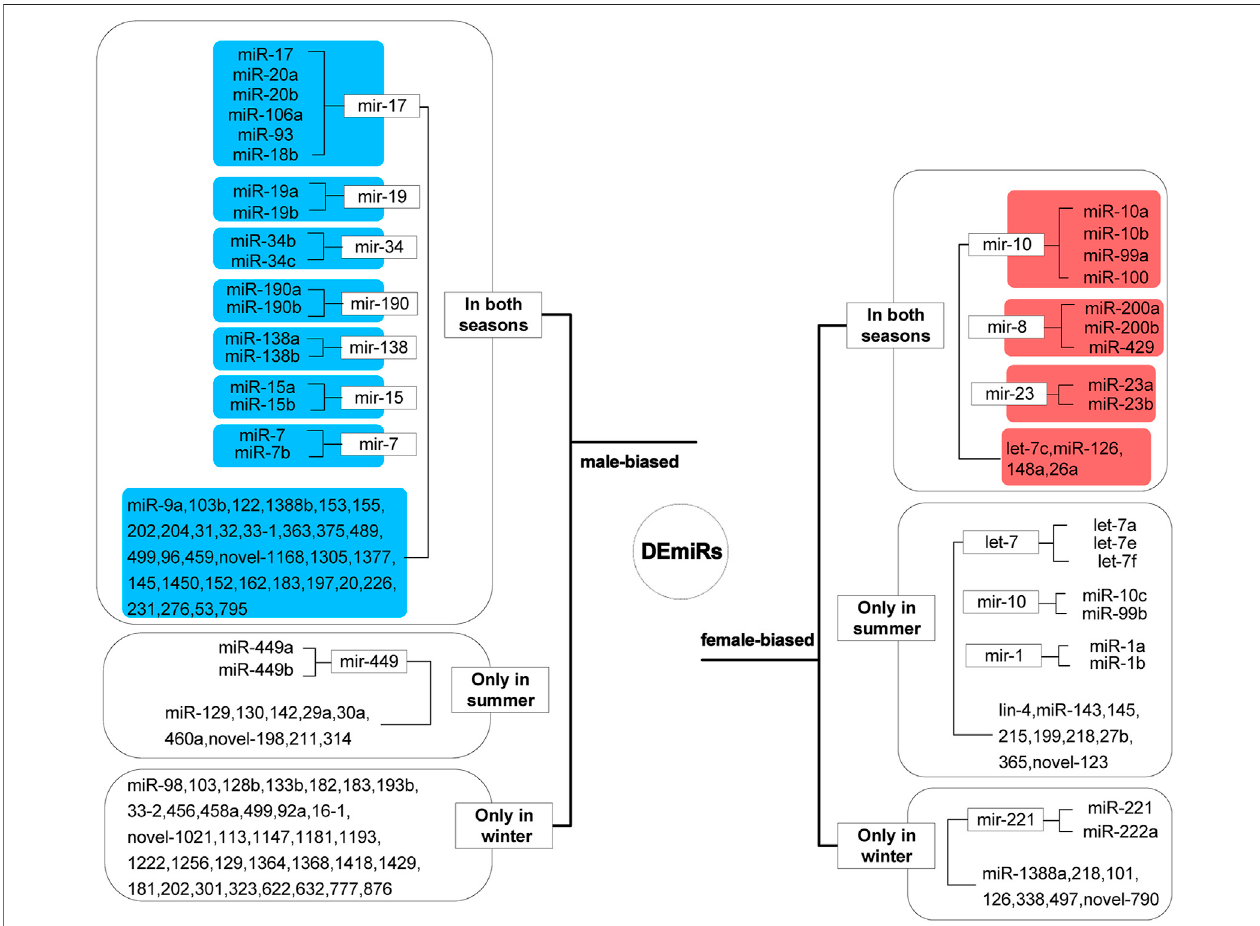
FIGURE 3 | Sex-biased differentially expressed miRNAs (DEmiRs). Sequences that were similarly biased in summer and winter are highlighted in blue and red, for male- and female-bias respectively.